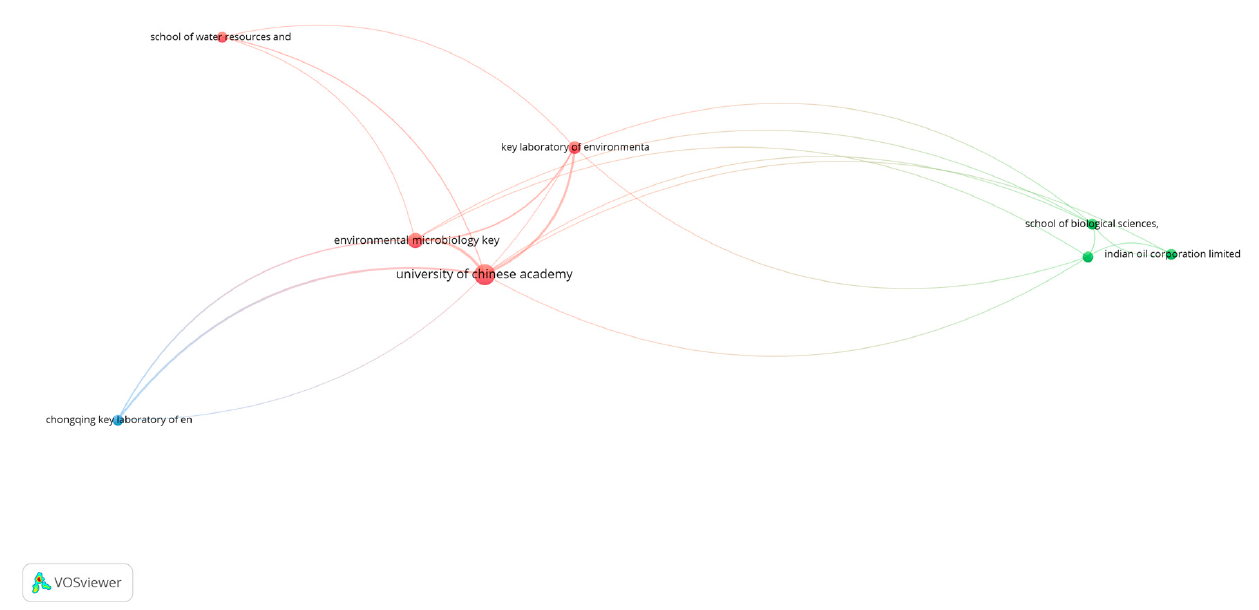
Figure 11. Co-citations of the organizations.